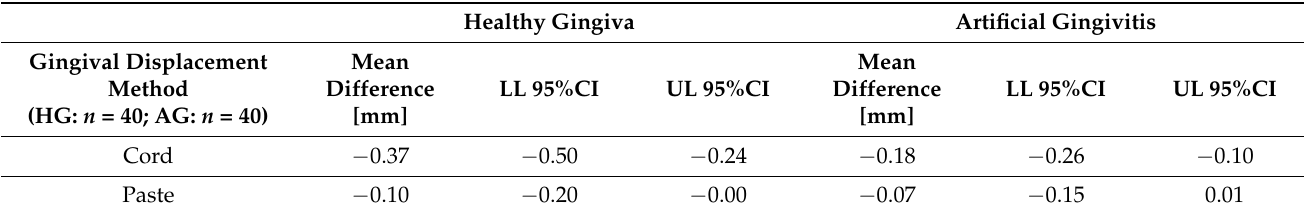
Table 2. Mean difference values in millimeters with lower (LL) and upper limit (UL) of 95% confidence interval (CI) of the sulcus representation for both gingival displacement methods, separately for healthy gingiva (HG) and artificial gingivitis